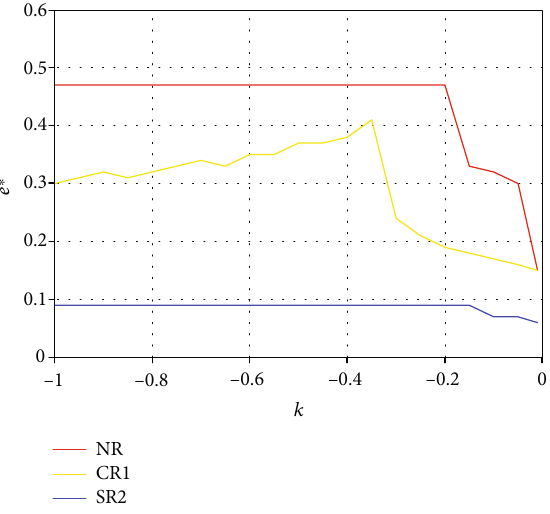
Figure 11: The stability domains of the ETDAS method in space ( k , e ∗ ) at R = 0 : 5